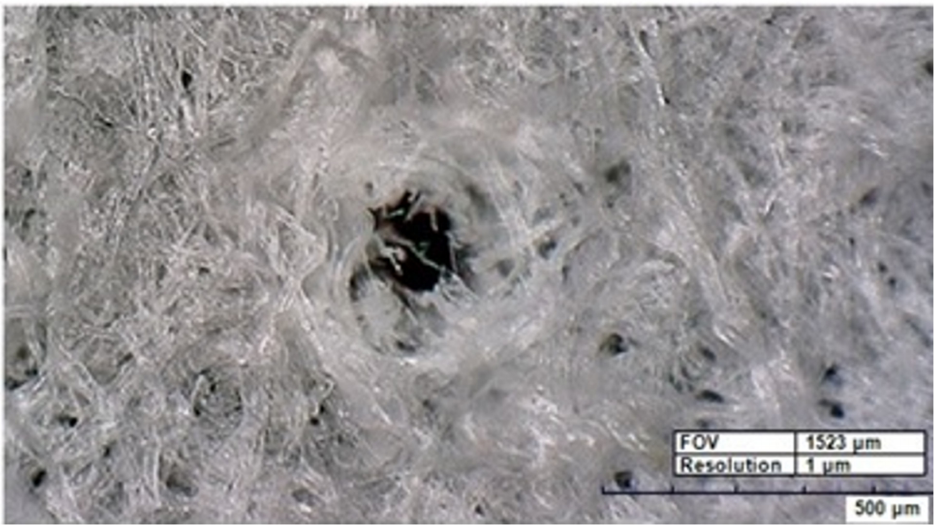
Figure 1. An exemplary view of a filter paper with Na solution after 3 laser